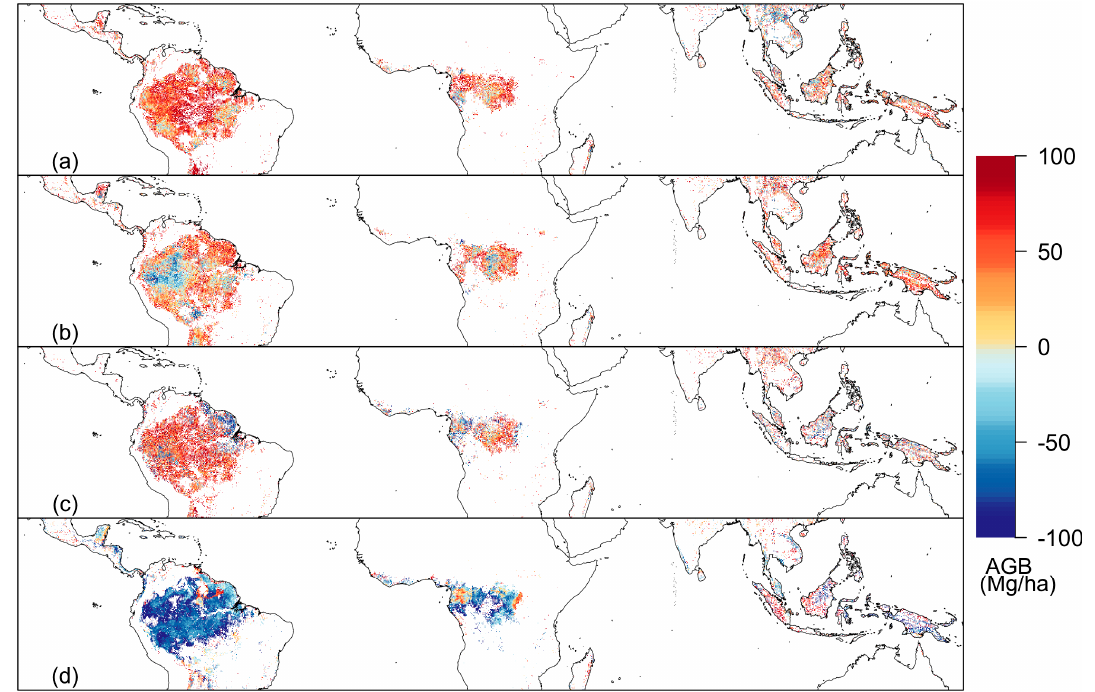
Figure 7. The difference map between our global wall-to-wall forest AGB product and the products from ( a ) Saatchi et al. (2011) [48]; ( b ) Baccini et al. (2012) [49]; ( c ) Avitabile et al. (2015) [72]; and ( d ) Reusch & Gibbs (2008) [73] in pan-tropical forest areas.